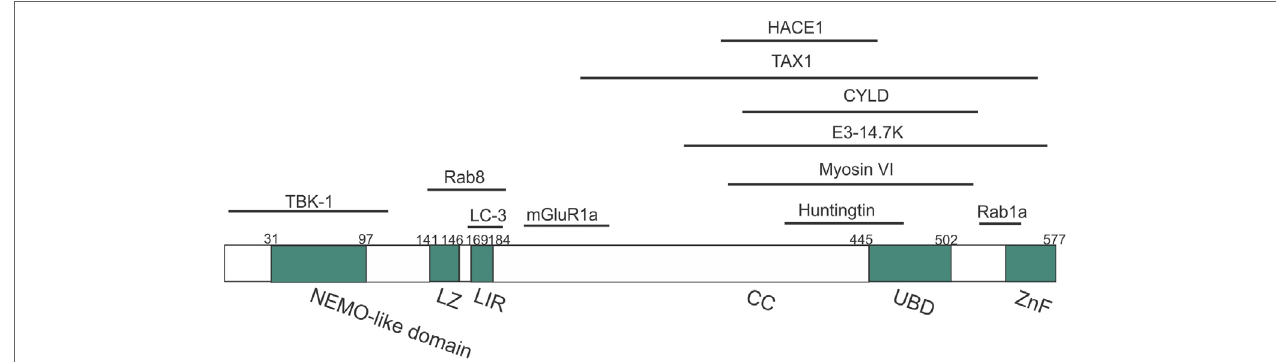
FiGURe 2 | Domain structure of optineurin, illustrating possible regions that associate with its binding partners. Optineurin consists of a NEMO-like domain, a LC3-interacting (LIR) domain, a LZ domain, an ubiquitin-binding domain (UBD), coil-coiled (CC) domains, and a zinc-finger-like (ZnF) domain. TBK-1, Rab8, LC3, and mGlutR1a bind to the N-terminus whilst HACE1, TAX1, E3-14.7K, myosin VI, huntingtin, and Rab1a bind toward the C-terminus.